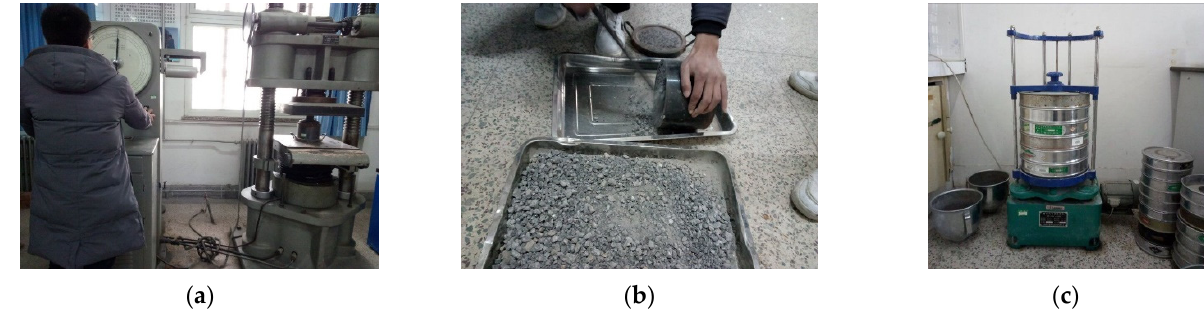
Figure 3. the test of coarse aggregate crushed index and the distributions of the rubber and aggregate particle size: ( a , b ) The test of coarse aggregate crushed index; ( c ) The test of distributions of the rubber and aggregate particle size.